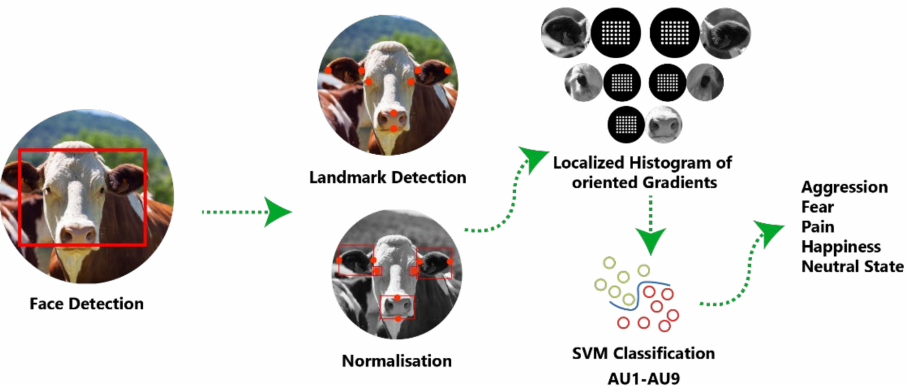
Figure 3. Pipeline of WUR Wolf (Wageningen University and Research—Wolf Mascot) automatic approach [102] in coding affective states from facial features of cows using machine learning models. SVM—support vector machine; AU—arbitrary